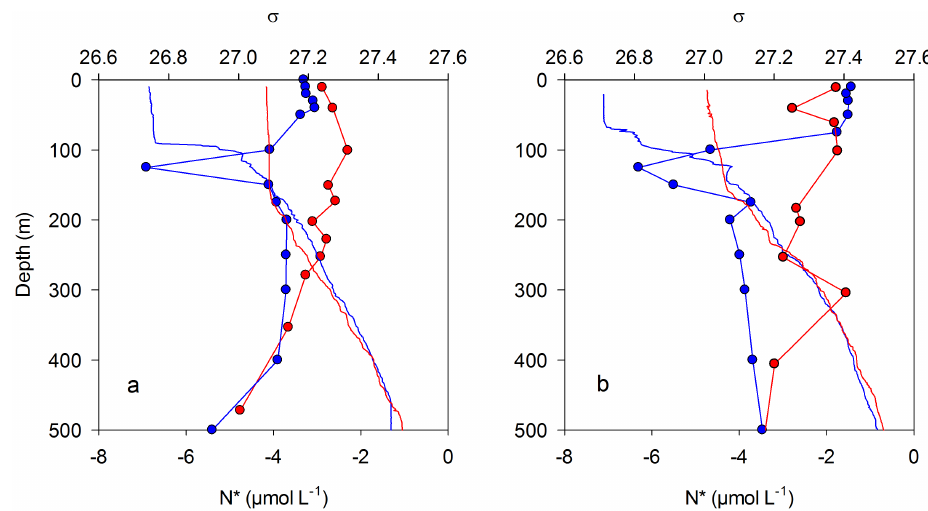
Figure 10. Depth profiles of N ∗ at stations A3 (a) and TNS-6 (b) for the month of November (in red) and February (in blue). Vertical profiles of density anomaly are shown with the same